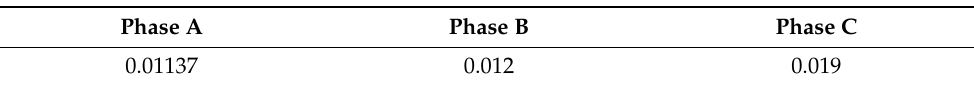
Table 4. Threshold value.